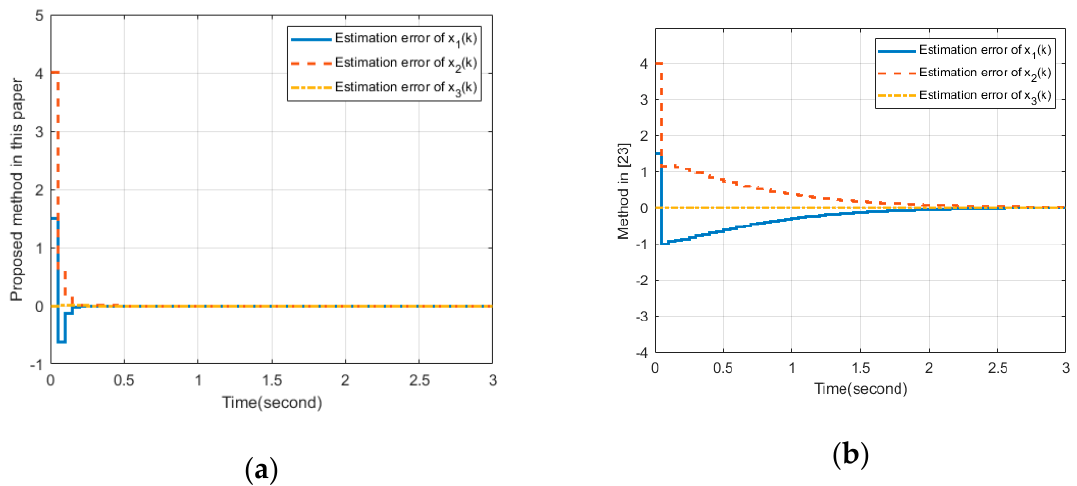
Figure 4. ( a ) Estimated state errors of the proposed design method; ( b ) Estimated state errors of the previous method [23].